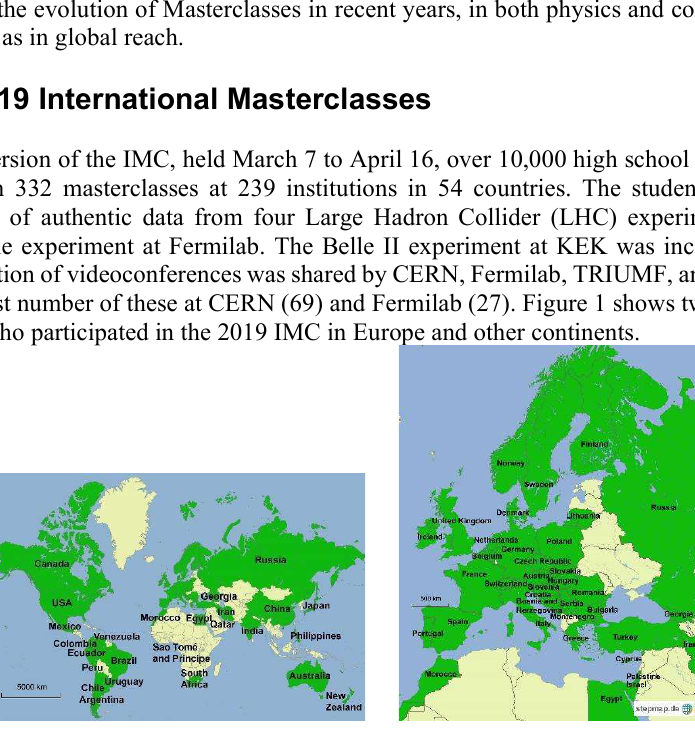
Figure 1. Countries involved in IMC 2019 from Europe (right) and other continents (left). Compared to the previous years (